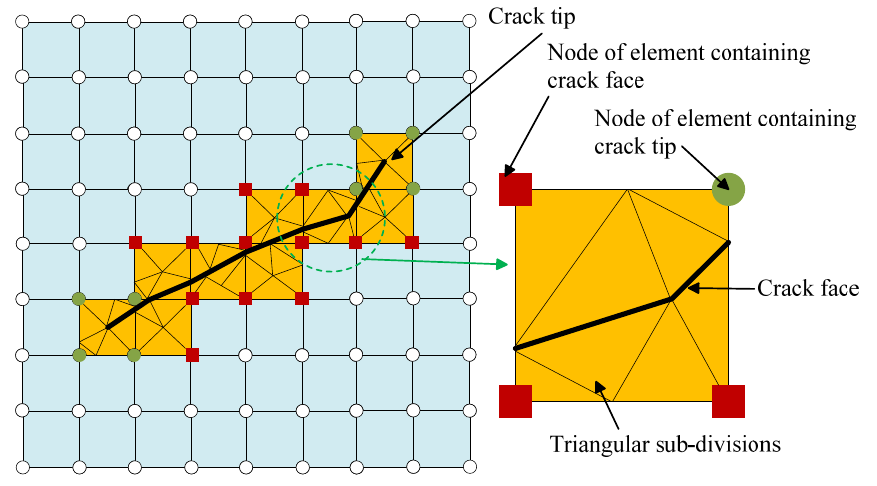
Figure 4. The triangular sub-divisions scheme of the numerical integration of crack discontinuity in the extended finite element method (XFEM).